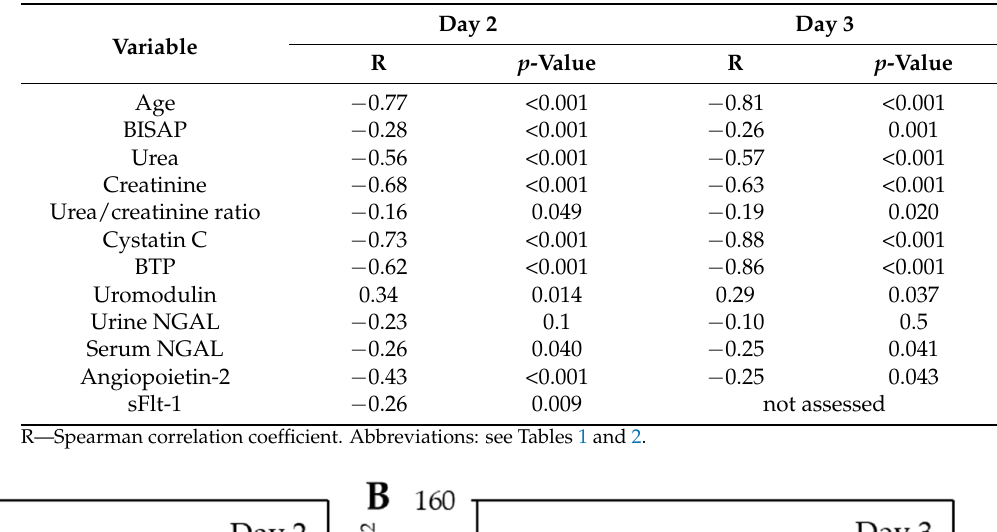
Table 3. Correlations between kinetic estimated glomerular filtration rate (KeGFR) values on day 2 and day 3 of hospital stay and the selected markers of AP severity and kidney function.